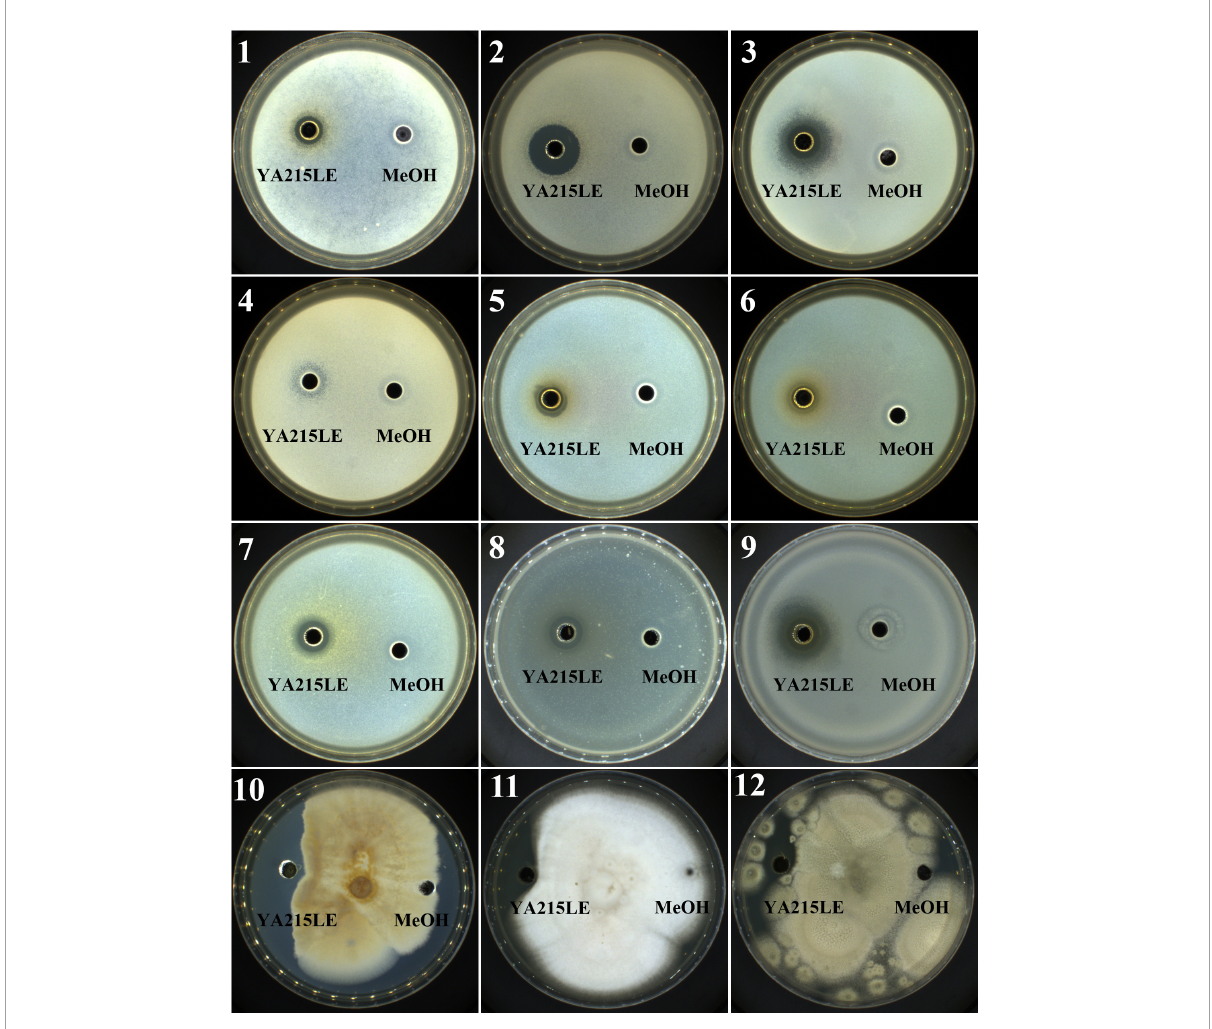
FIGURE2 Demonstration of the inhibitory effects of YA215 lipopeptide extracts (YA215LE) against phytopathogenic bacteria and fungi (panels 1-12). (1) Bacillus licheniformis , (2) Bacillus cereus , (3) Staphylococcus aureus CGMCC26003 , (4) Bacillus nanotuberculosis , (5) Bacillus subtilis CGMCC1.14985 , (6) Bacillus subtilis CGMCC1.15792 , (7) Escherichia coli CGMCC44102 , (8) Salmonella typhimurium CGMCC11190 , (9) Shigella flexneri CGMCC110599 , (10) Fusarium oxysporum f.sp.cubense , (11) Rhizopus stolonifer CGMCC3.31 , (12) Penicillium expansum CICC 40658 .